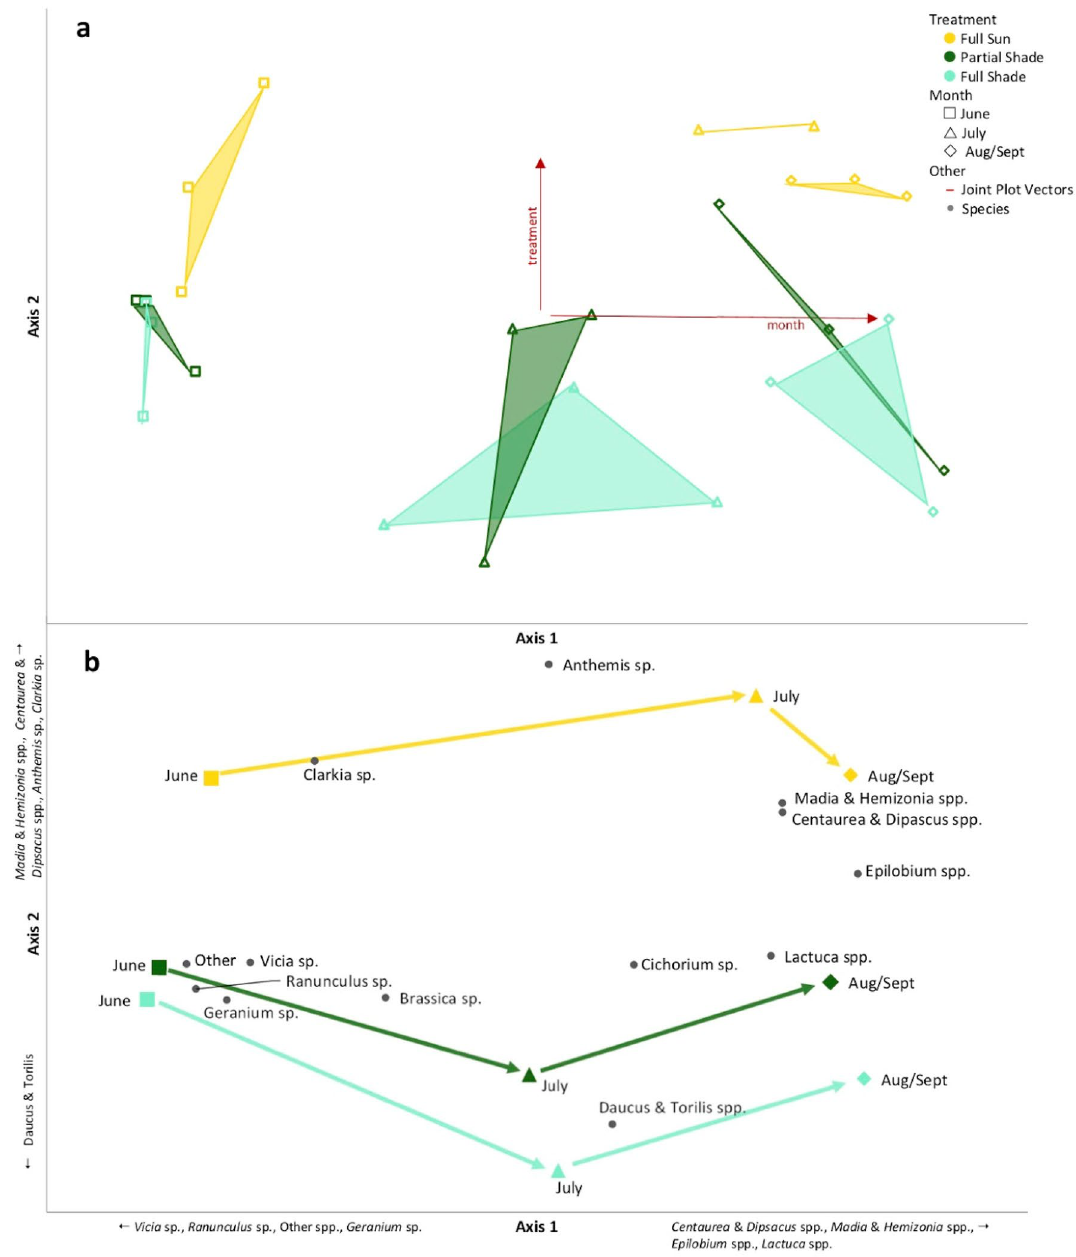
Figure 5. ( a ) Plant community composition described through a nonmetric multidimensional scaling of sample units (averaged by month) in insect species space, with weighted average positions shown for species significantly correlated with axes. Sample units that are close together in the graph are more similar (in species composition) than those that are farther apart. Convex hulls connect groups of treatments (by month). Colored, un-filled symbols represent sample units. Black circles represent species. Joint-plot vectors (red lines) show environmental variables correlated with the axes, vector length represents correlation strength. ( b ) Successional vectors connect centroids from each group of treatments (by month) to illustrate community change over time. Colored, filled symbols represent centroids. Black circles represent species. Fundamental coordinates were generated and data exploration was conducted in PC-ORD Software version 7.07 47 . Figure linework and aesthetics were created in Microsoft PowerPoint